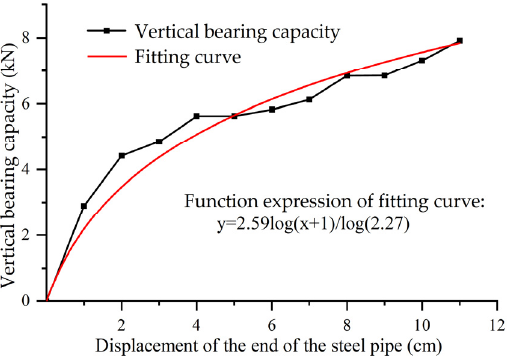
Figure 9. Simulated stress deformation curve of steel pipe under end load.